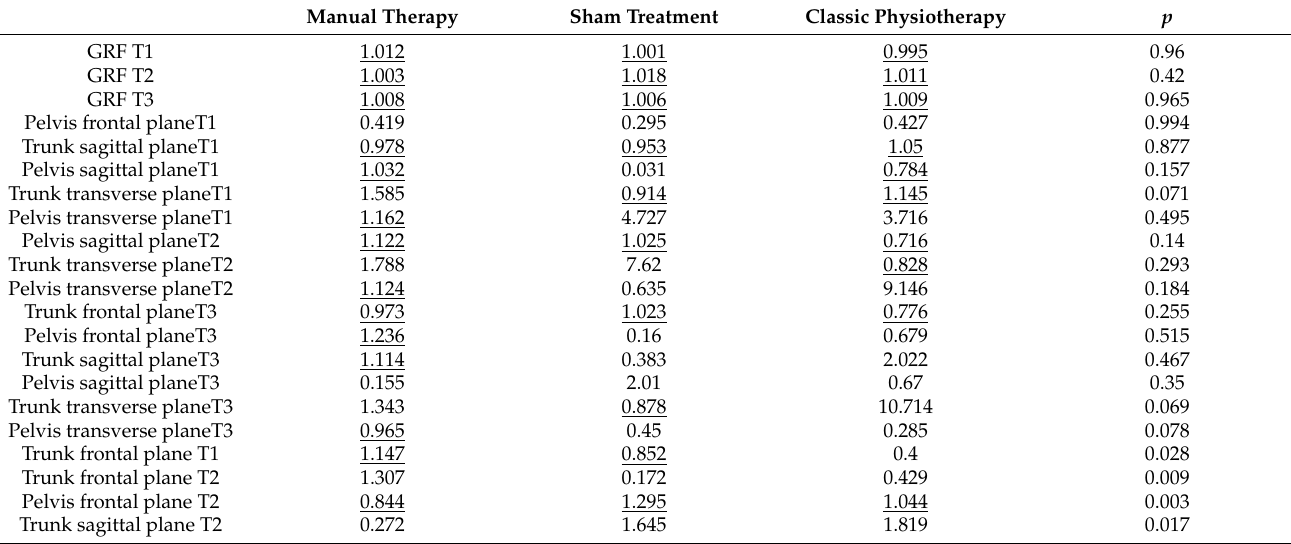
Table A4. Gait symmetry in absolute numbers—between-group differences in the R-L ratio. Manual